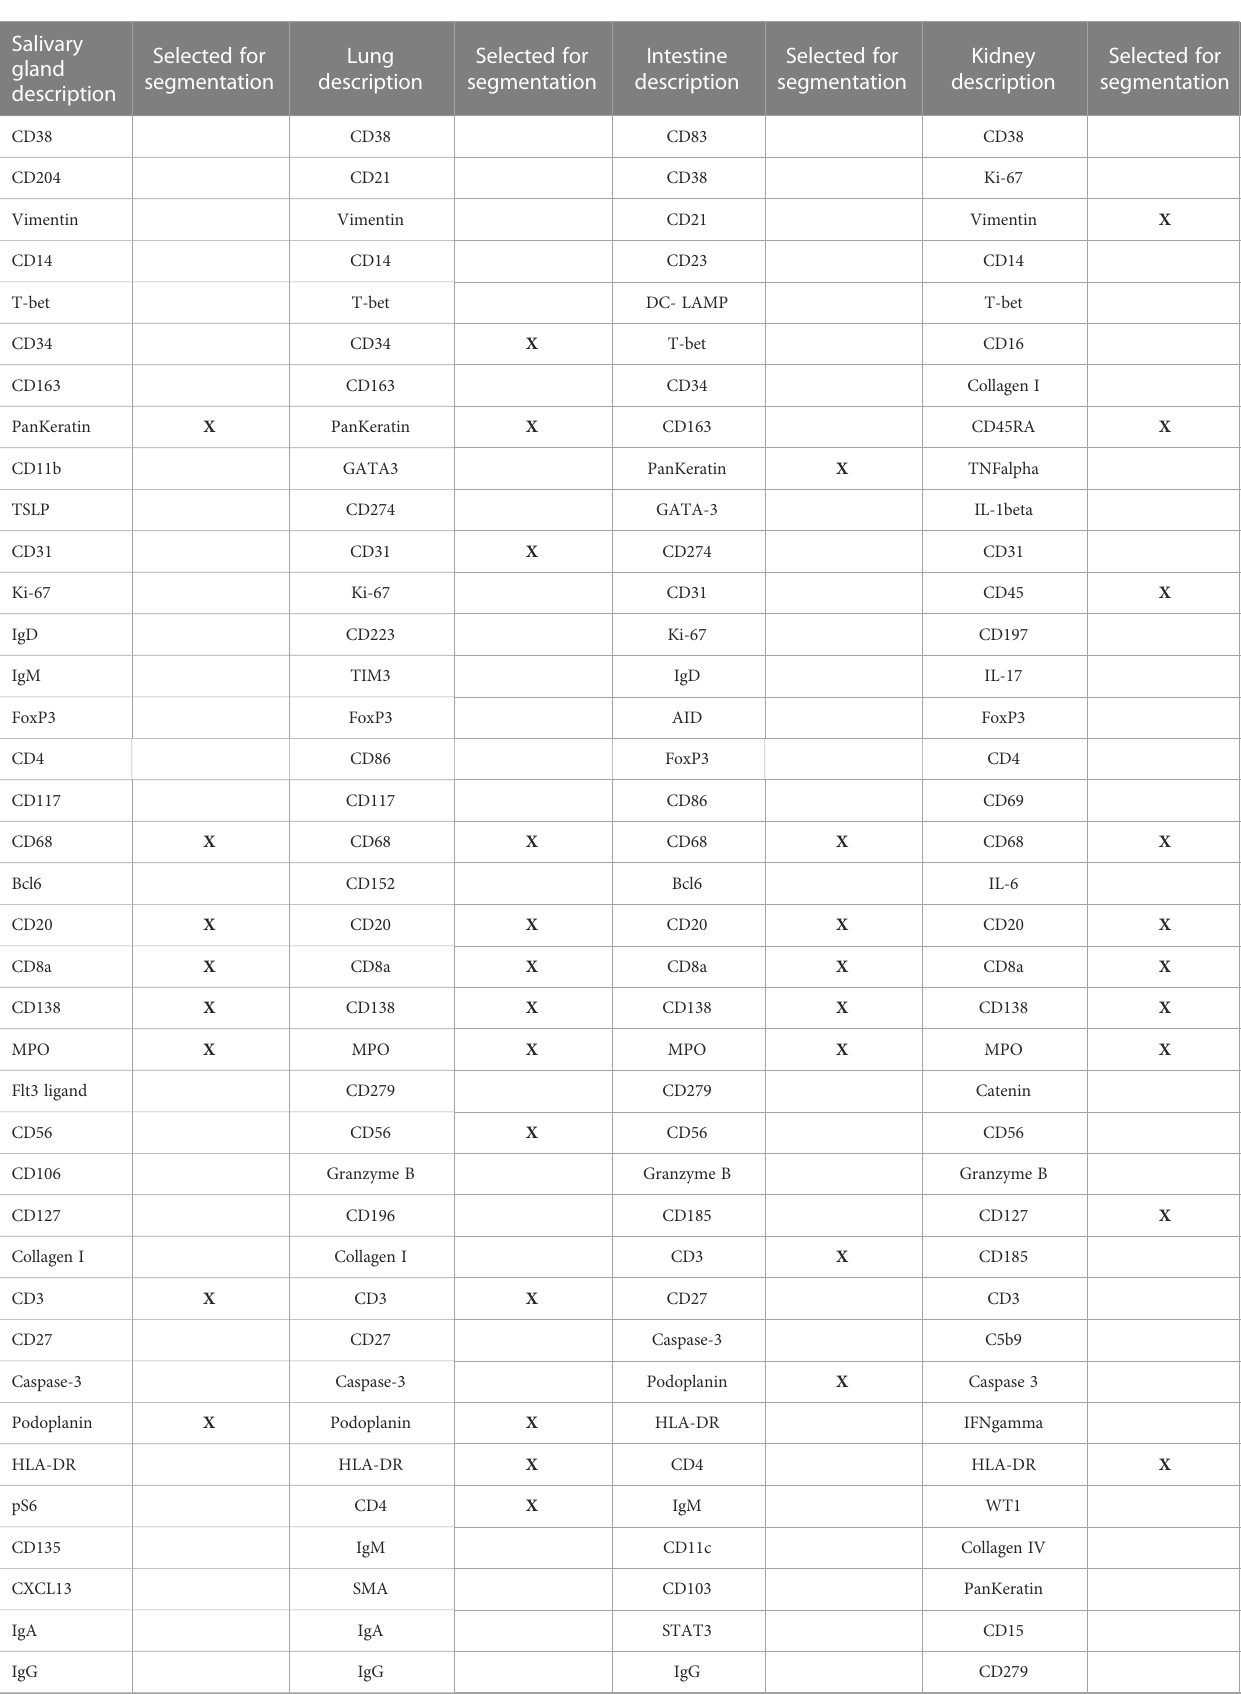
TABLE 1 Panels of markers for the imaging mass cytometry